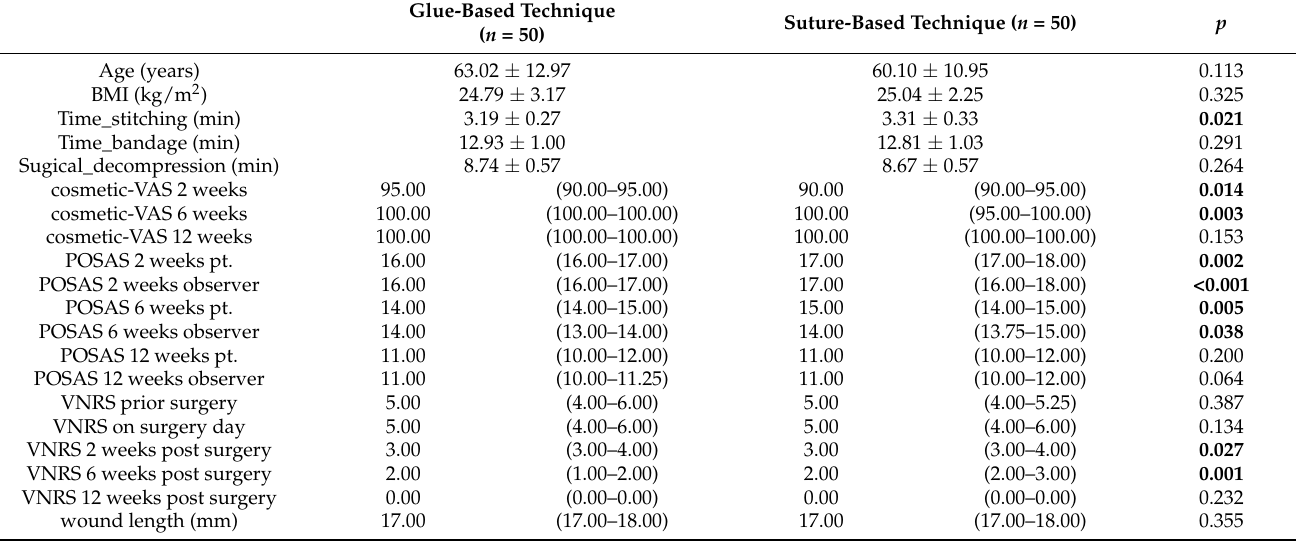
Table 2. Differences between glue-based wound closure and suture-based wound closure patients (Student’s t -test for independent samples or Mann–Whitney test for non-parametric data), and p - values for significant differences are bolded. Data are presented as the arithmetic mean ± standard deviation, or median (interquartile range) for non-parametric